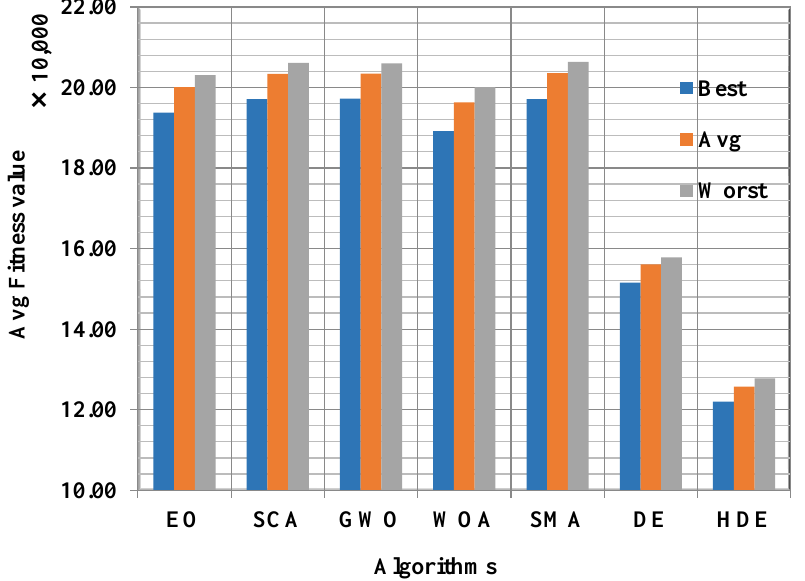
Figure 4. Comparison among algorithms by fitness value.